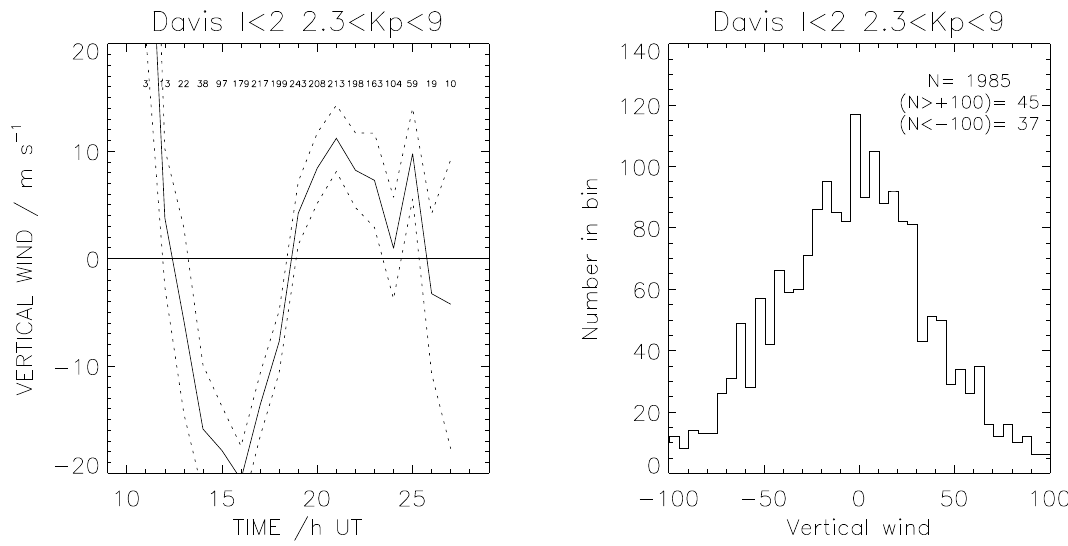
Fig. 9. As in Fig. 8 except for low intensity, high K p . Only Davis values are given, since insufficient data were available from Mawson. The majority of these measurements would be from the polar